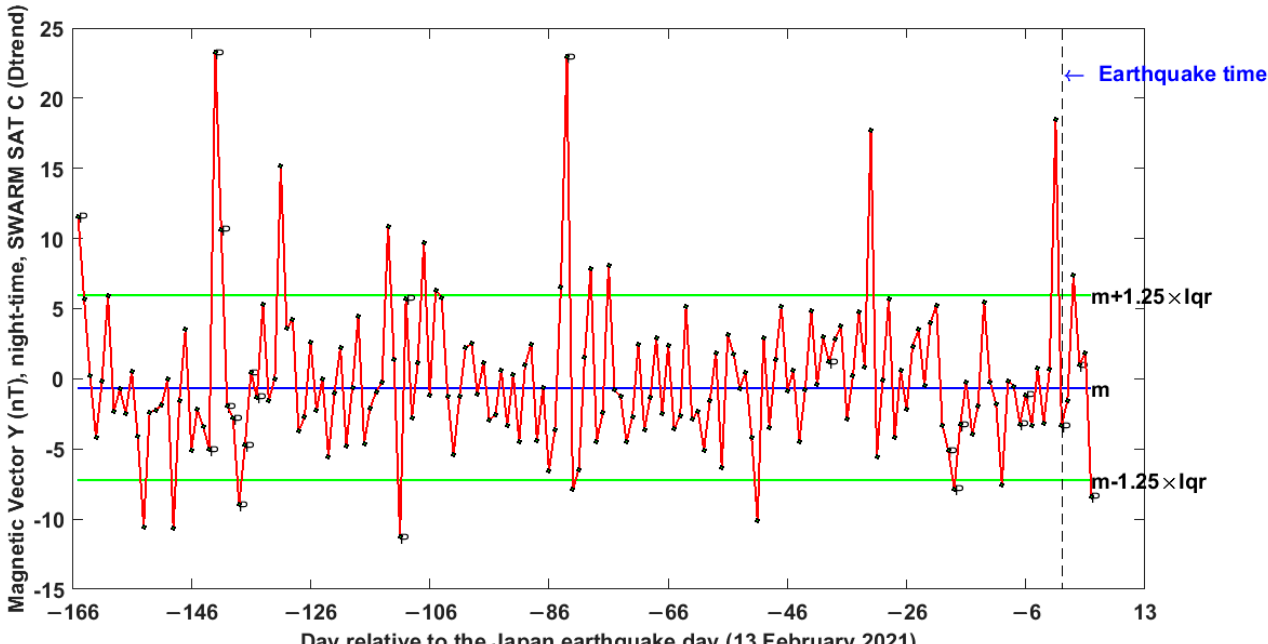
Figure 10. Results of Y magnetic field data analysis from Swarm C for the Japan earthquake (13 February 2021) from 1 September 2020 to 18 February 2021 at night-time. The geomagnetically “per- turbed” days are highlighted by a “P”.